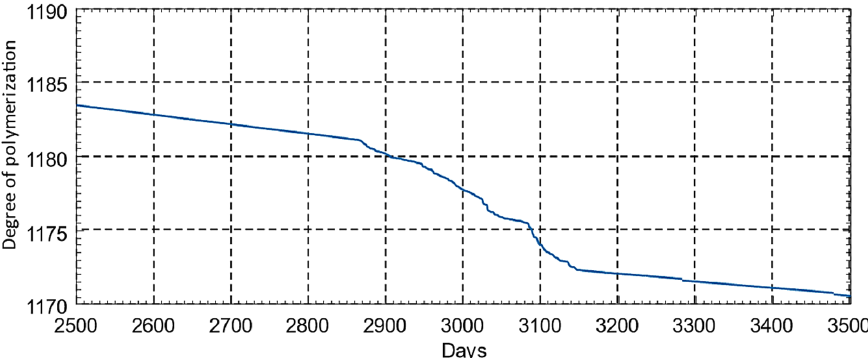
Figure 50. Simulation of the degree of polymerization since the transformer’s commissioning date.